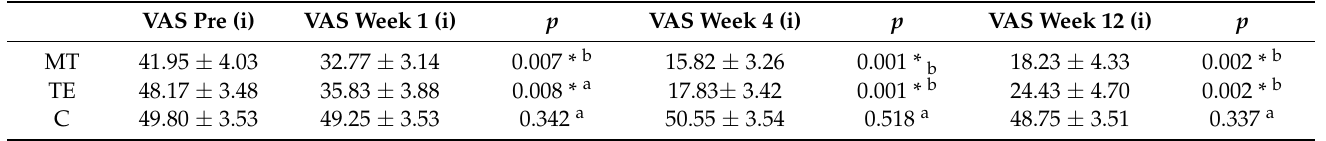
Table 2. Intergroup analysis for VAS.